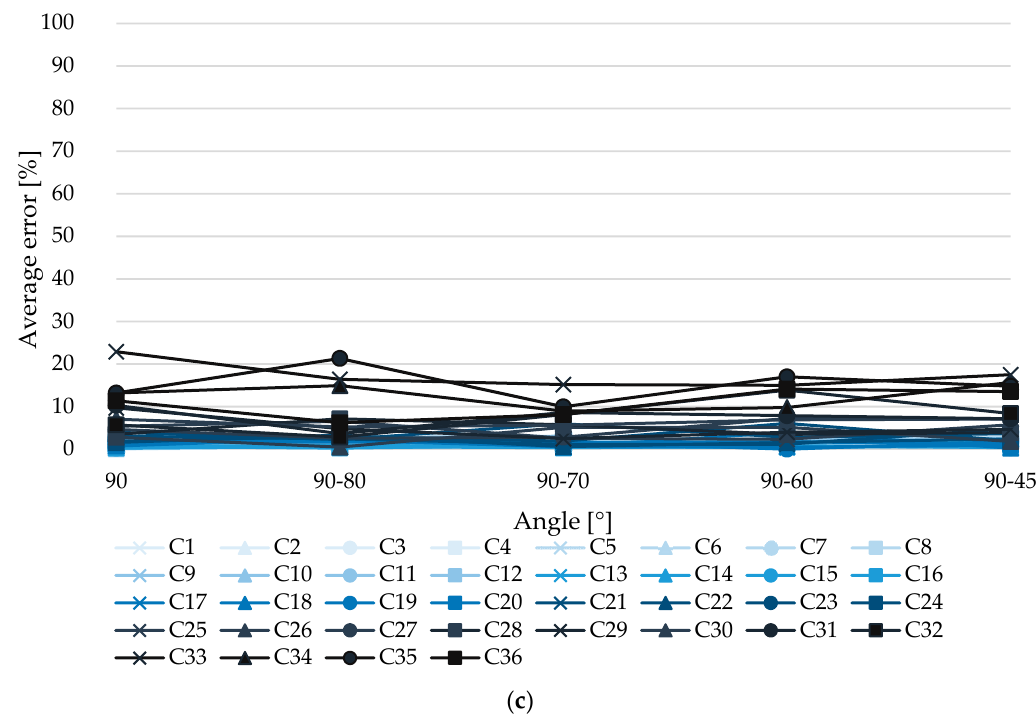
Figure 6. Average relative error severity of width for different severity levels. ( a ) low severity; ( b ) mean severity; ( c ) high severity.